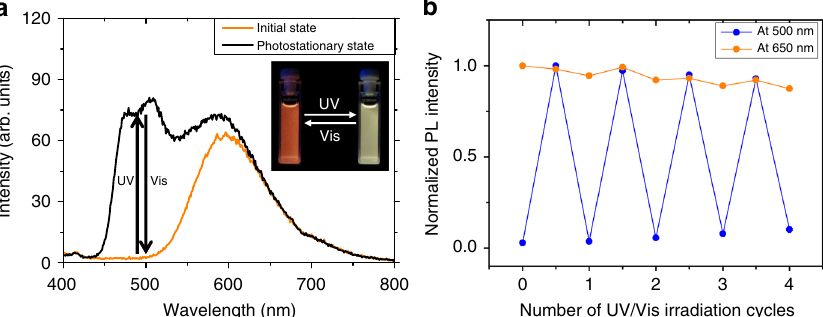
Fig. 6 Emission properties in nanoparticles. a PL spectra changes of the PCL nanoparticle containing DBTEO and HPNIC (DBTEO:HPNIC = 1.5:1 doped in PCL, the total concentration of dyes to PCL matrix is 1 wt%) upon UV and visible-light irradiations. The inset is a photograph of fl uorescence switching in the nanoparticle. b Reversibility test of the nanoparticle with alternation of UV and visible-light